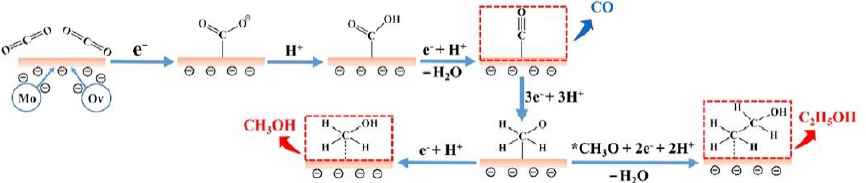
Figure 3. Proposed reaction pathway of photocatalytic CO 2 reduction to methanol and ethanol. Reproduced with permission from reference [42].